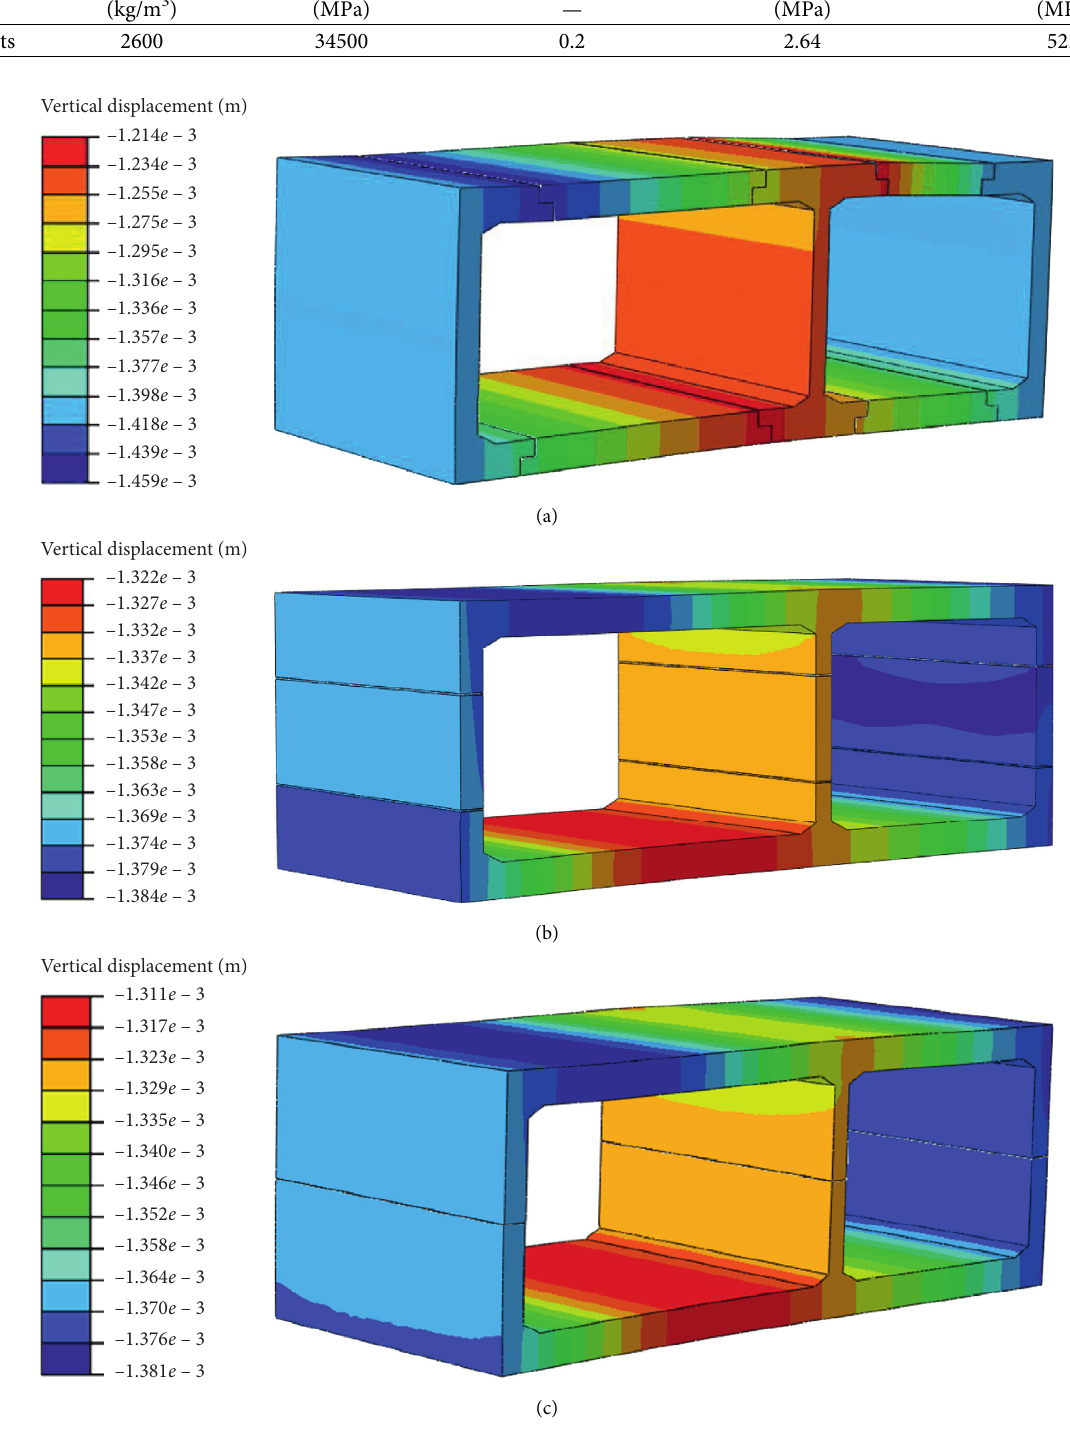
Figure 6: Vertical displacement of various schemes: (a) scheme 1, (b) scheme 2, and (c) scheme